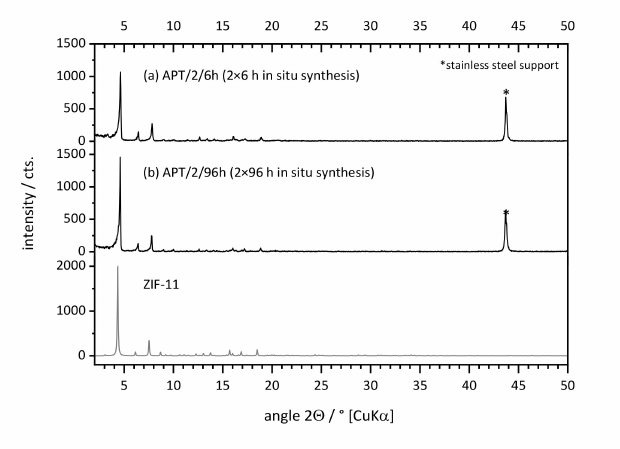
Figure 5. SEM images ( a ) of a pristine stainless-steel support (APT) and stainless-steel supports (APT) after two consecutive ZIF-11 syntheses for ( b ) 6 h and ( c ) 96 h in DEF at 60 ◦ C.